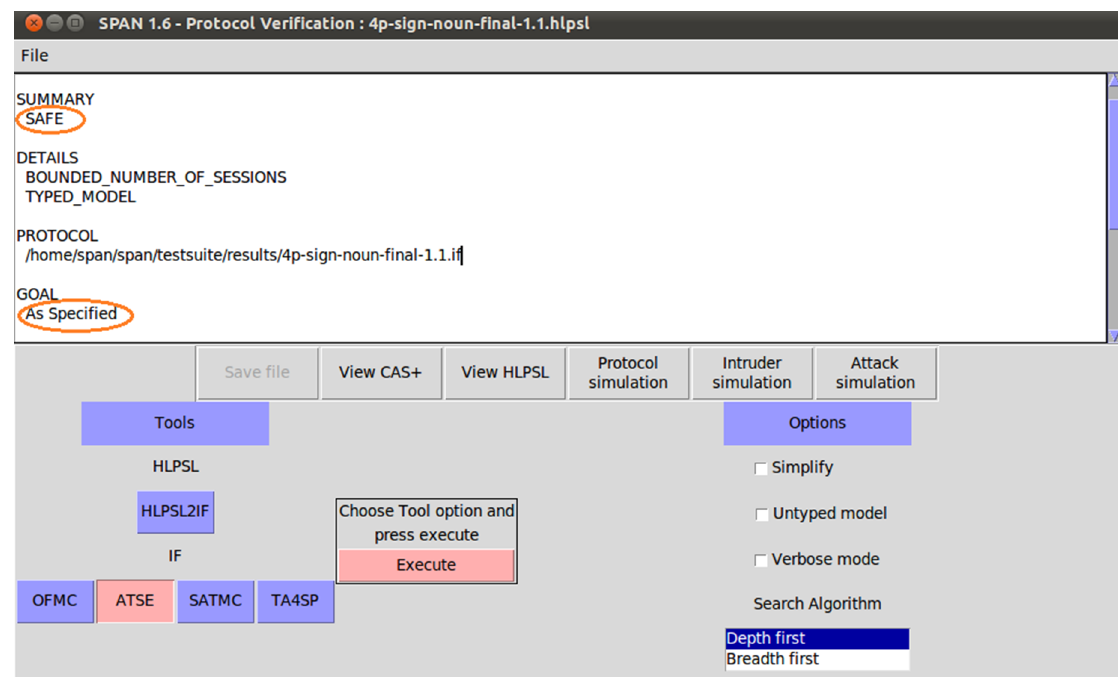
Figure 9. Simulation analysis result according to Dolev–Yao model.